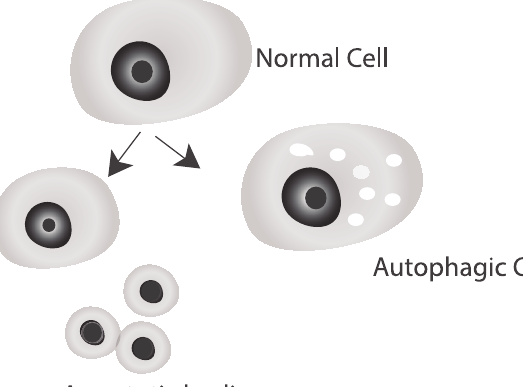
Figure 1 - Schematic view of the cell death by apoptosis with the cell size shrinking and fragmentation to form apoptotic bodies and autophagic cell with